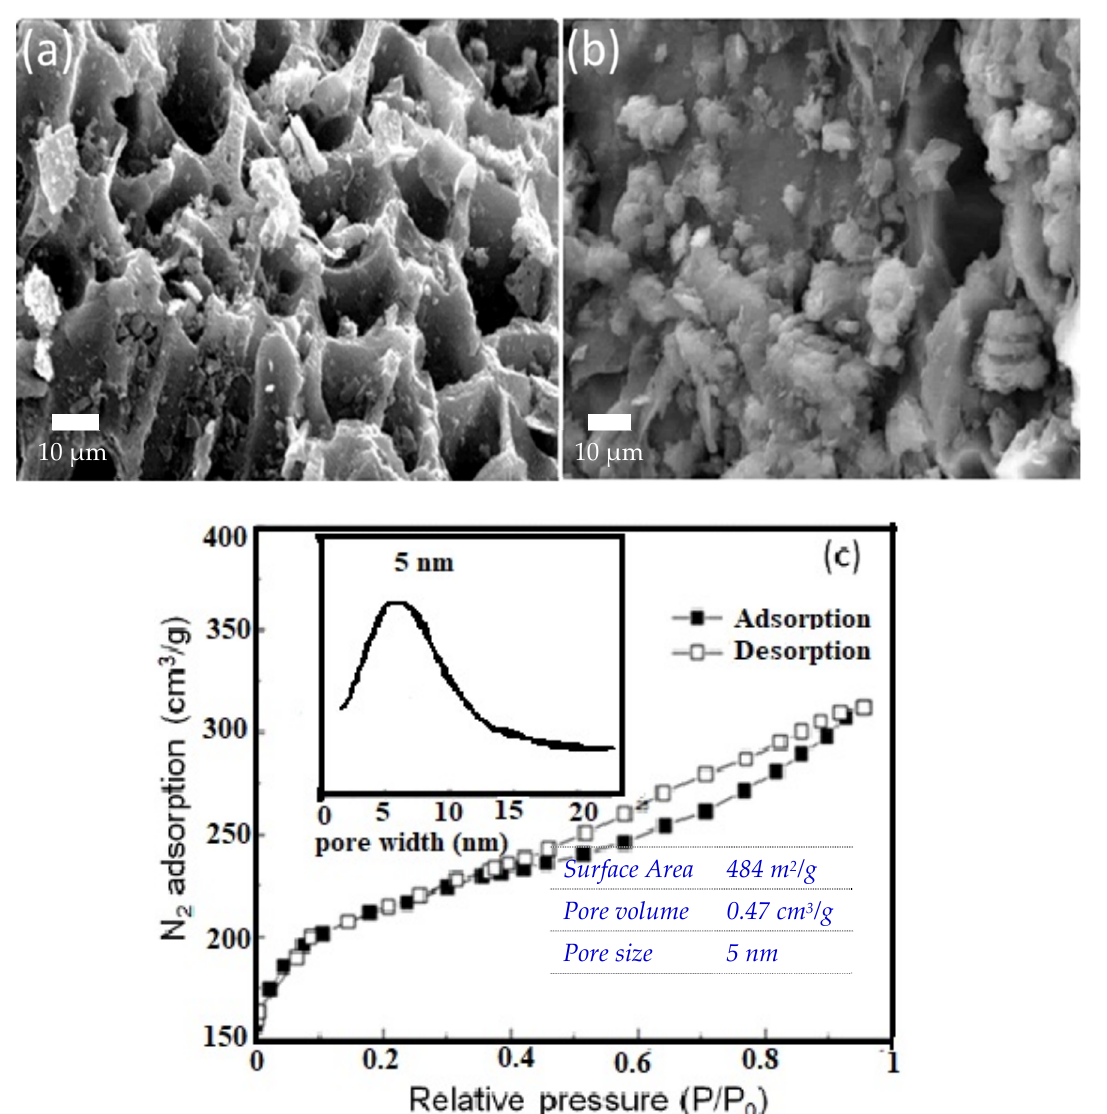
Figure 1. SEM images of ( a ) the AFAC before and ( b ) after adsorption of AZM and ( c ) the N 2 adsorption-desorption isotherm. The inset of Figure 1c shows the pore size distribution curve of AFAC. Table 1. Surface-structural properties of the